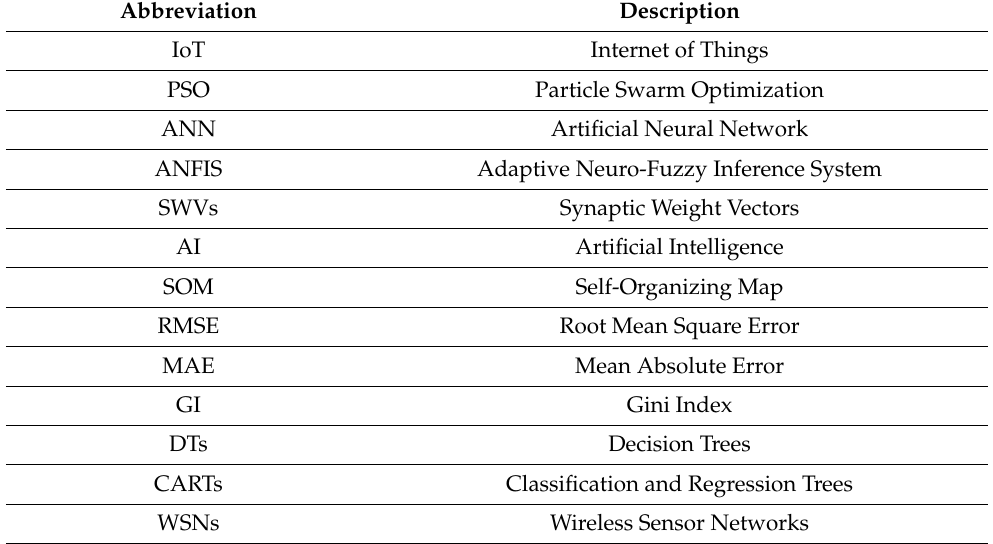
Table 1. Abbreviations used in this